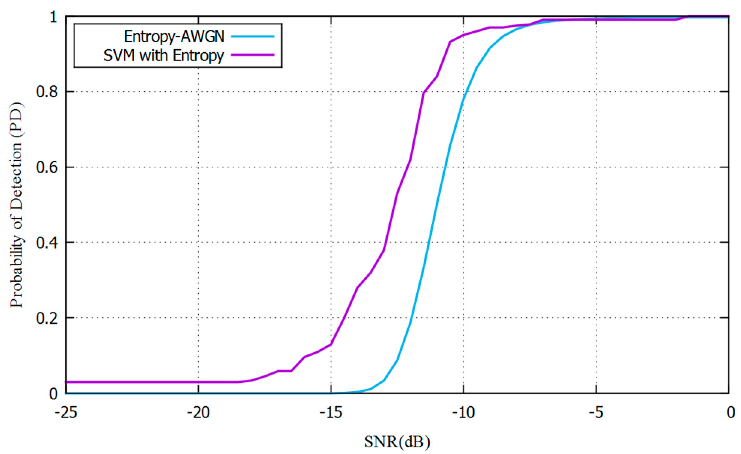
Figure 12. Probability of detection with SVM vs. entropy for OFDM.